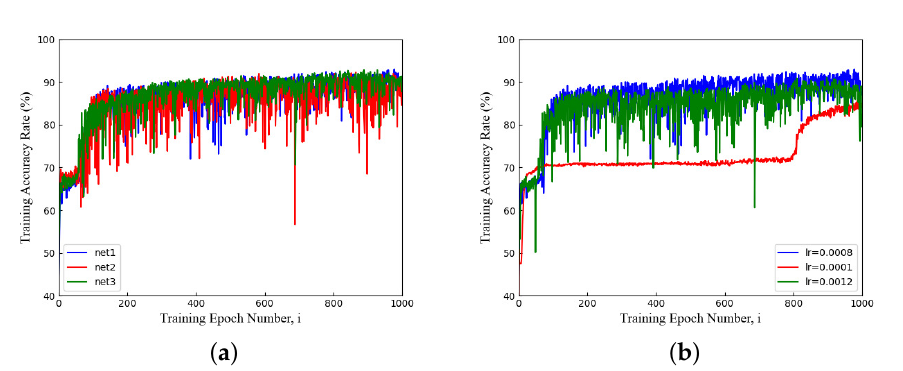
Figure 5. Different layers, neurons, and learning rates affect the accuracy of the neural network replicating human decision-making process. ( a ) neural network; ( b ) learning rate.